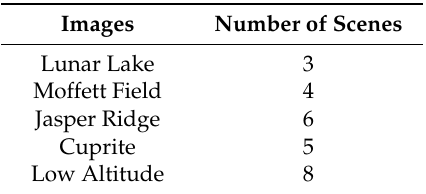
Table 1. Description of the dataset used.